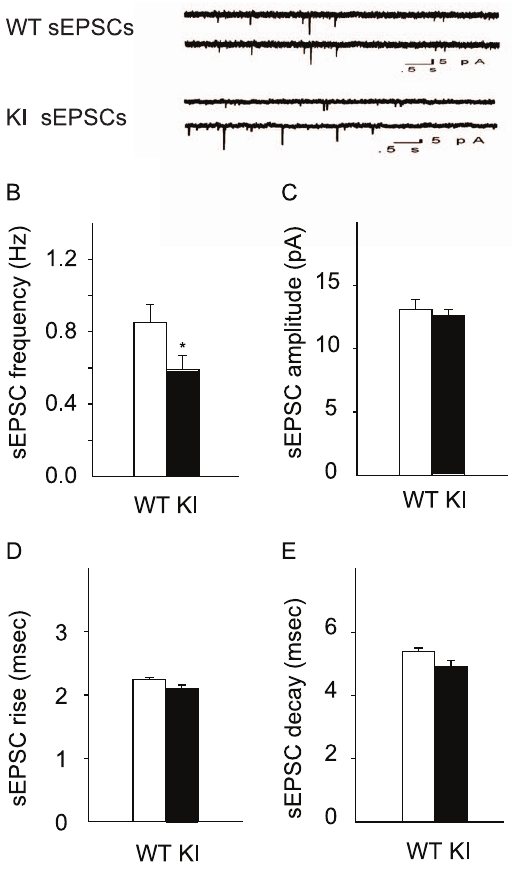
Figure 2. Decreased frequency of sEPSCs in Dyt1 D GAG heterozygous KI mice. (A) Representative traces for sEPSCs. Dyt1 D GAG heterozygous KI mice had a significantly decreased frequency of sEPSCs (B), but no change in either the amplitude (C), or rise (D) and decay (E) times of these events. The vertical bars represent means 6 standard errors. * p , 0.05.